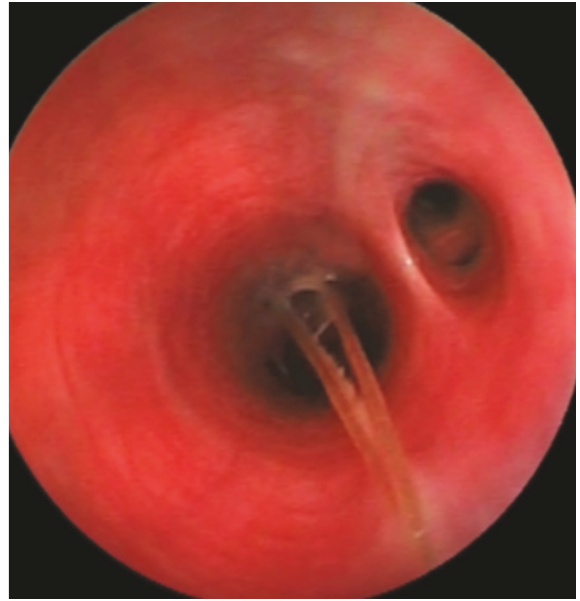
Figure 2: Grass awn in a bronchus during endoscopy